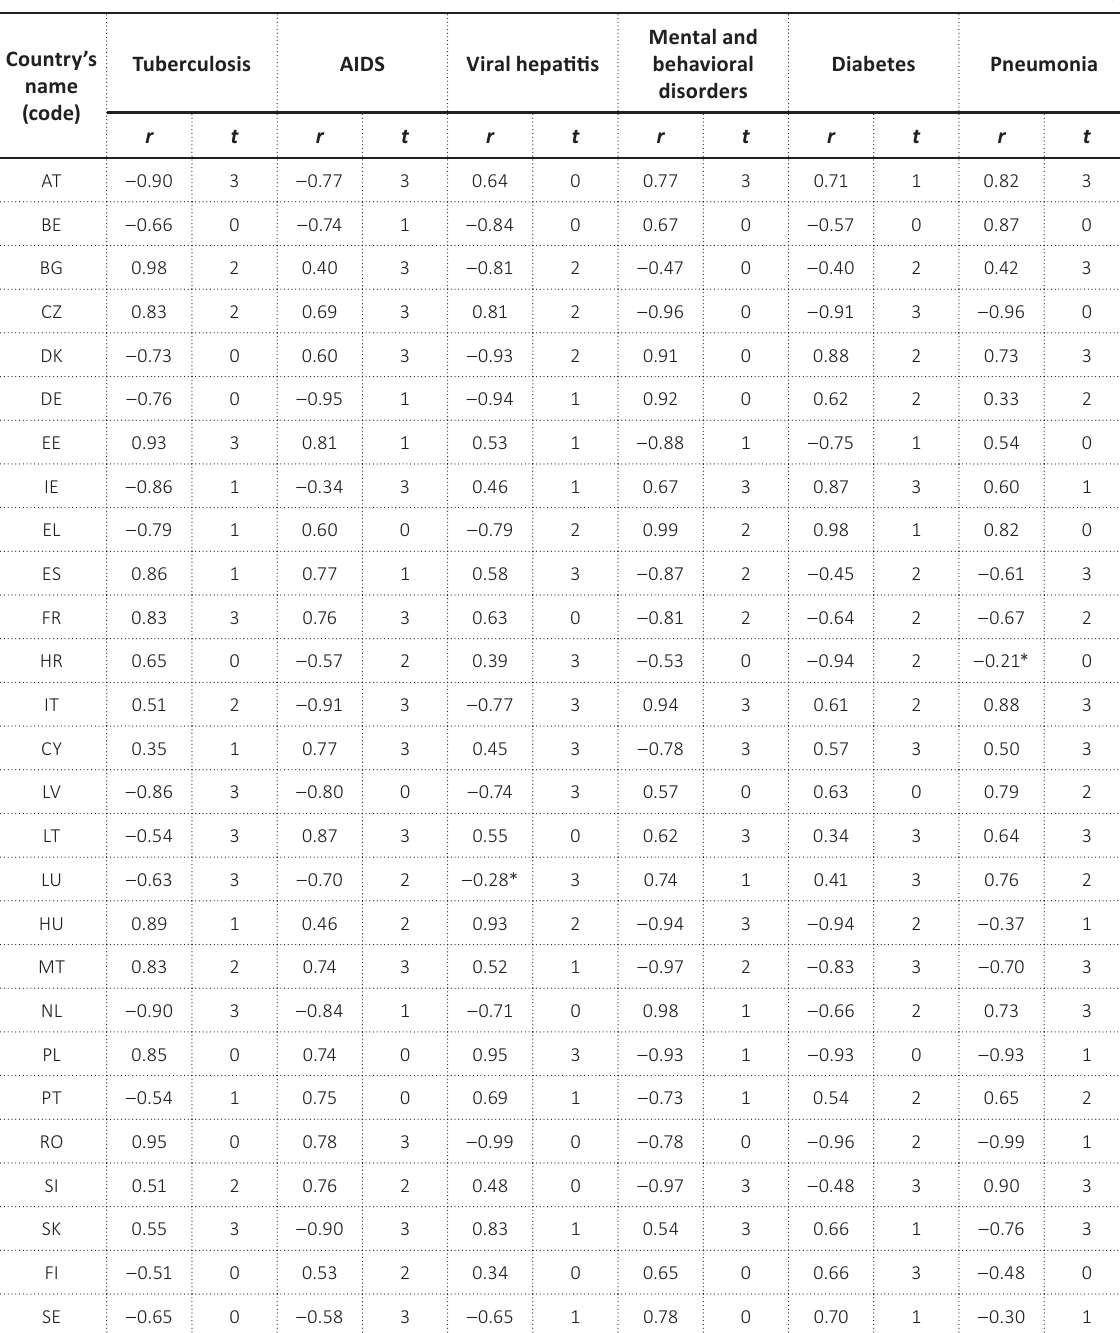
Table A1. Statistical significance, nature, and strength of the impact of changes in the level of overcrowding on changes in mortality from a number of dangerous diseases (a sample from 27 EU countries for 2011–2019) Source: Calculated by the authors in the STATA software